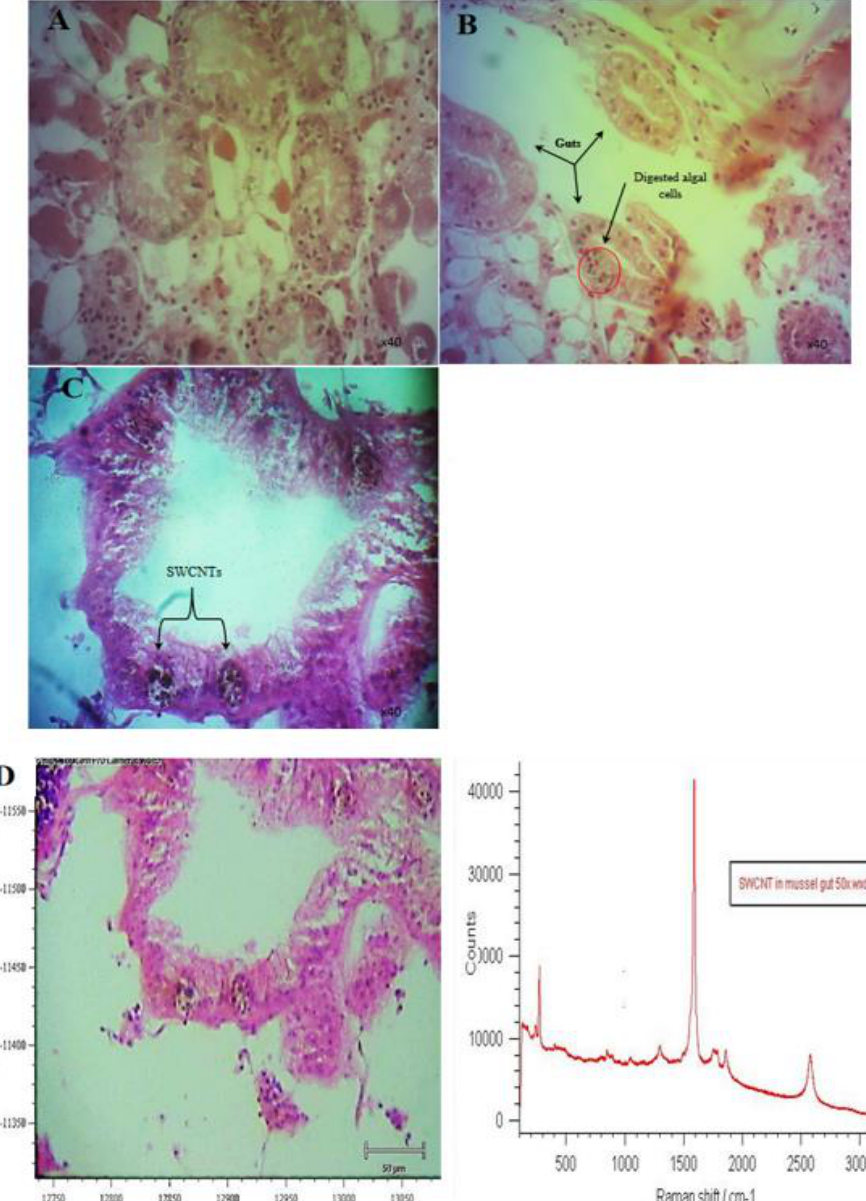
Figure 15. The gut from mussels exposed to algal cells-SWCNT 500 µ g L − 1 . Histological sections of mussel’s gut in ( A ) control tissue, ( B ) digested algal cells, and ( C ) SWCNTs in gut, ( D ) Raman spectrum of the histological sections of the digestive gland of mussel confirming uptake of SWCNTs; scale bar (50 µm).